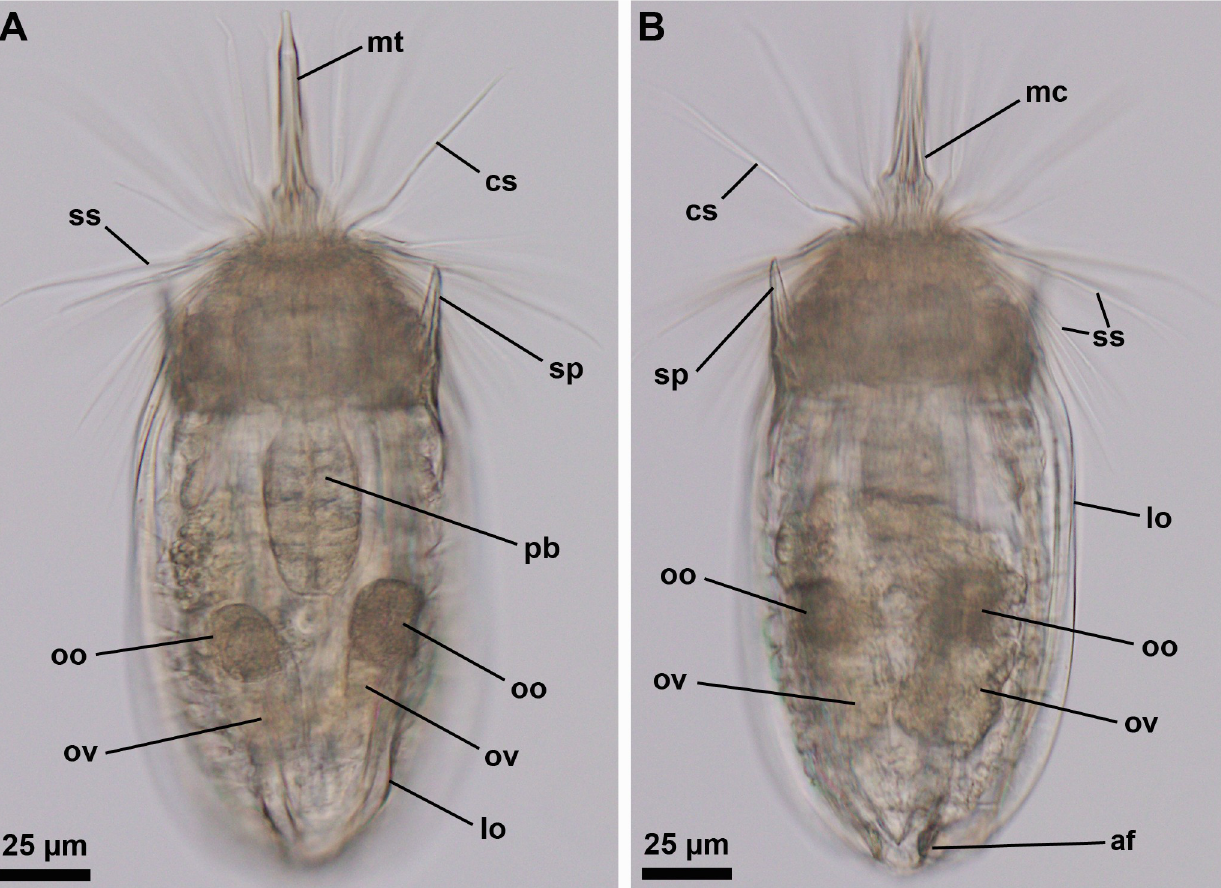
Fig 13. Light micrographs of a live adult female of Nanaloricus mathildeae sp. nov. Anterior faces up in both aspects. Note the video sequence of this animal in the S1 Video. (A and B) Overview of the body with partly extended introvert and mouth cone. Internally, note the presence of a large oocyte (oo) within each ovary (ov) in the abdomen. Note also the shape and relative position of the pharyngeal bulb (pb). Abbreviations: af, anal field; cs, clavoscalid; lo, lorica; mc, mouth cone; mt, mouth tube; sp, anterior spike; ss spinoscalid.